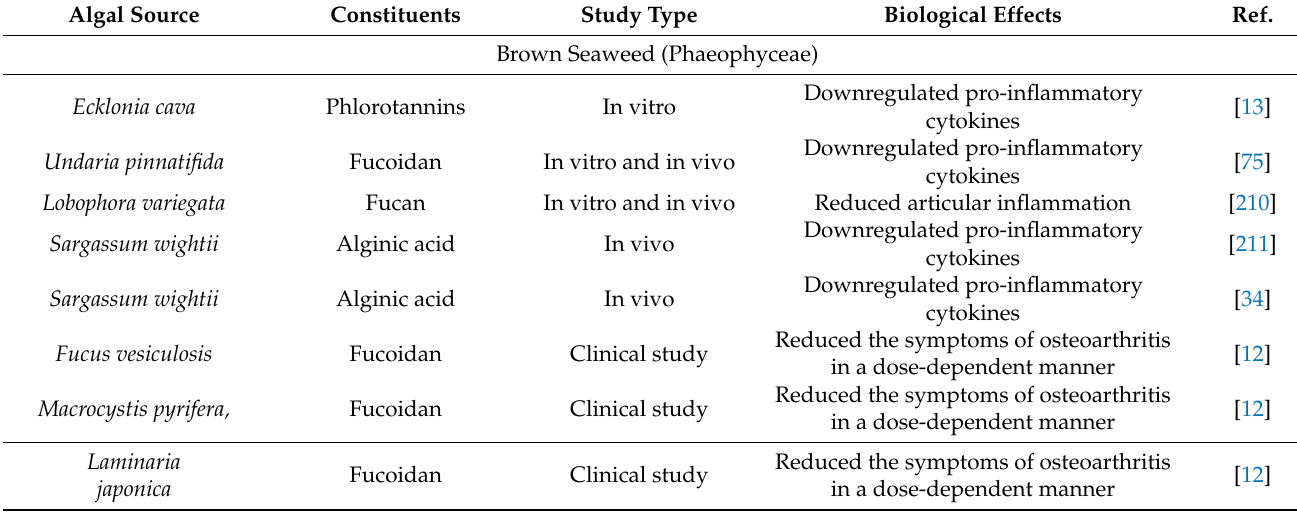
Table 7. The effect of seaweed-derived compounds on